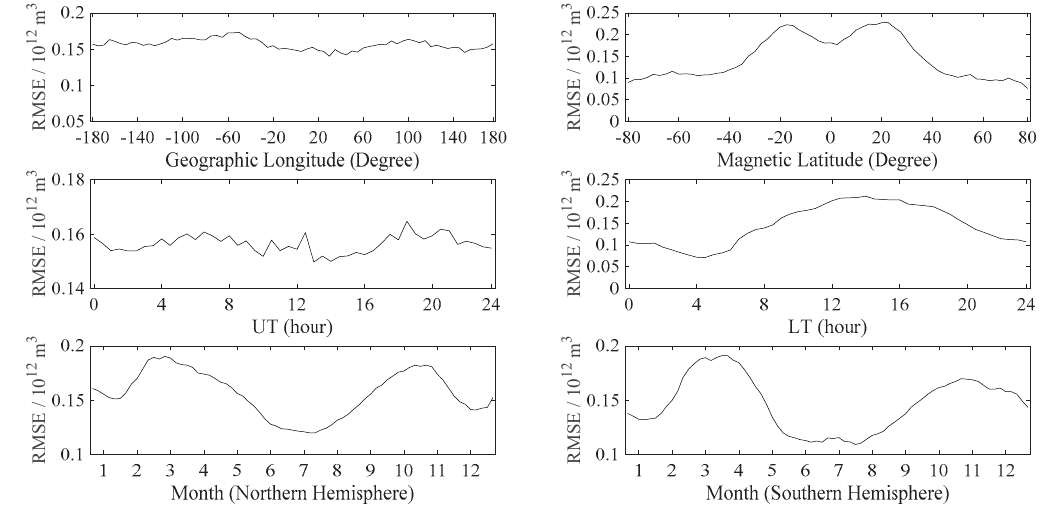
Figure 3. Distributions of RMSE with geographical longitude, magnetic latitude, universal time, local time, and day of year.